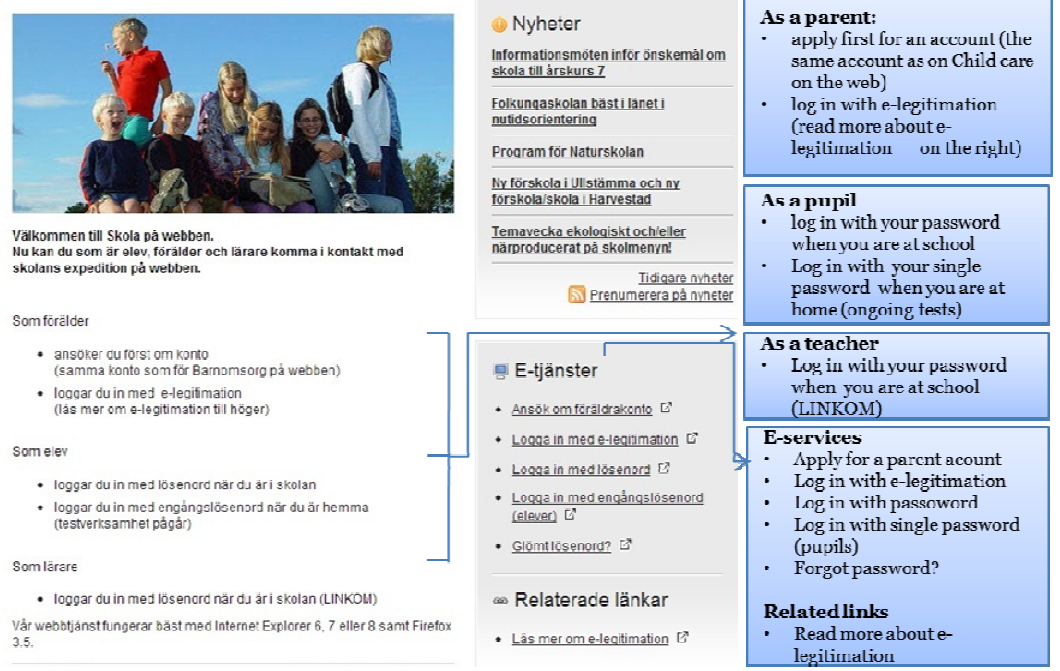
Figure 1. DEXTER snapshot, log in